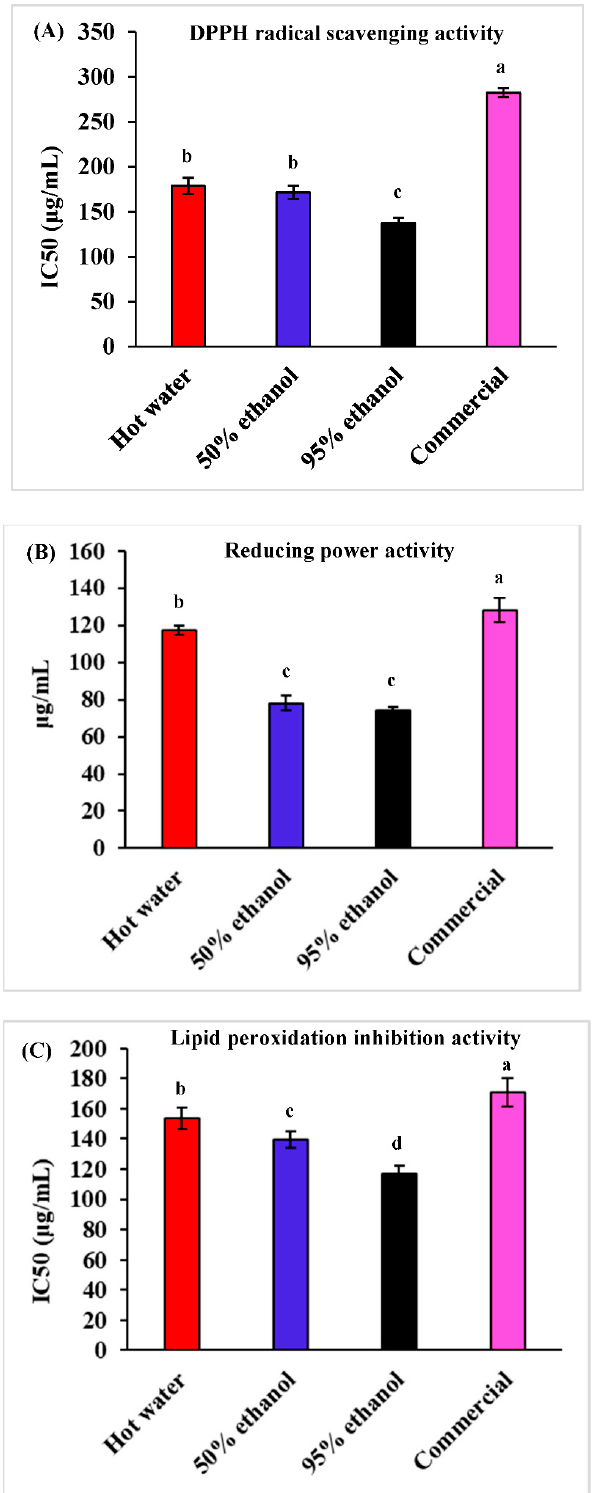
Figure 2. Effect of Phyllanthus emblica L. fruit extracts on DPPH radical scavenging activities ( A ), reducing power activity ( B ) and inhibition of lipid peroxidation ( C ). Values with different superscript letter (a, b, c, and d) indicate significant difference ( p < 0.05) by Duncan’s multiple range